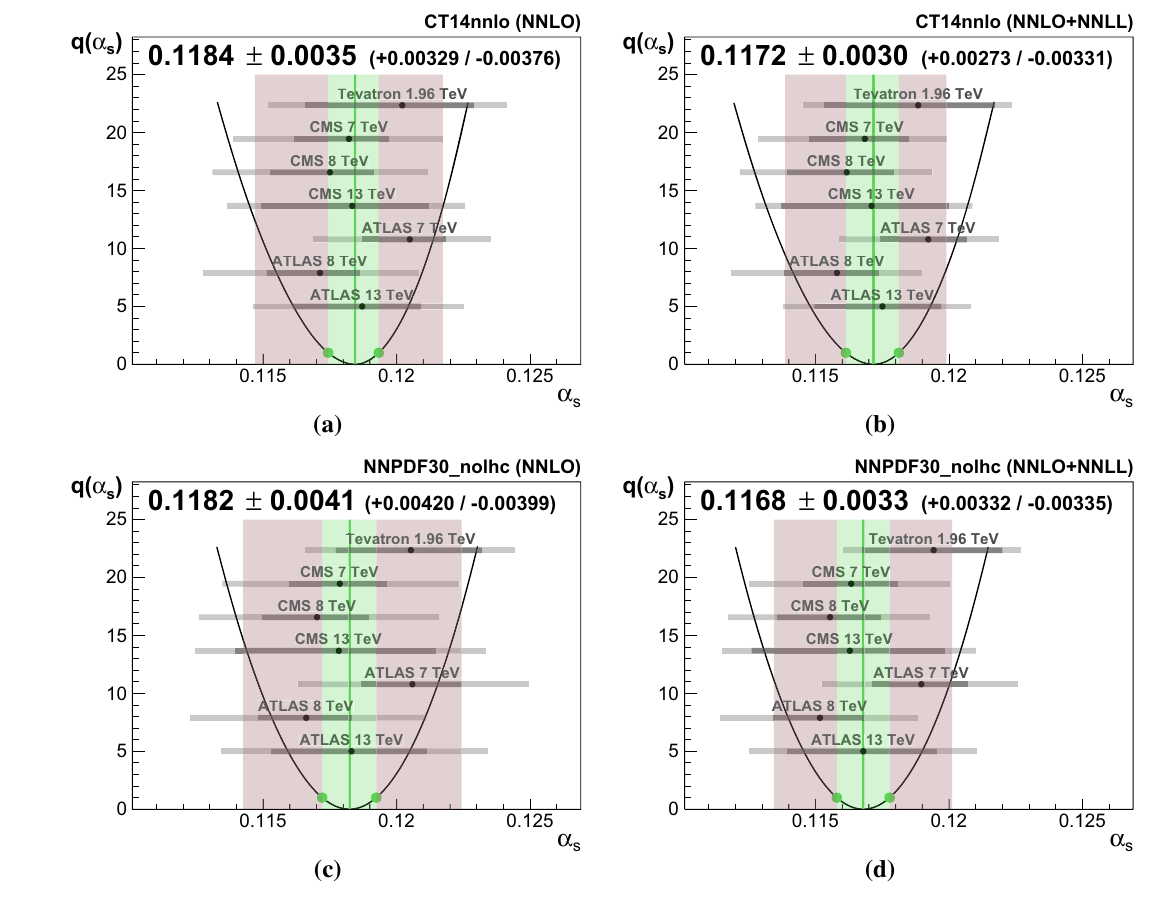
Fig. 3 Combination results using the CT14 PDF set (NNLO in a and NNLO + NNLL in b ) and the NNPDF3.0 noLHC PDF set (NNLO in c and NNLO + NNLL in d ). The individual determinations and their uncertainties are shown in grey, where the darker shade represents the experimental uncertainties which enter into the combination. The test